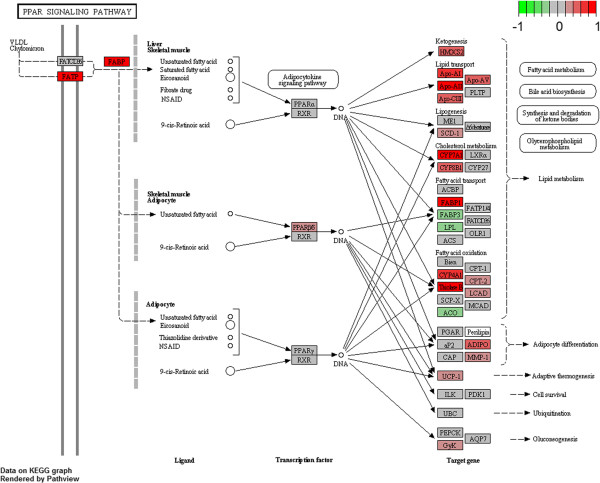
PPAR signaling pathway from KEGG. Genes are colored according to their GSEA calculated scores: the most marked red genes belong to the core enrichment.